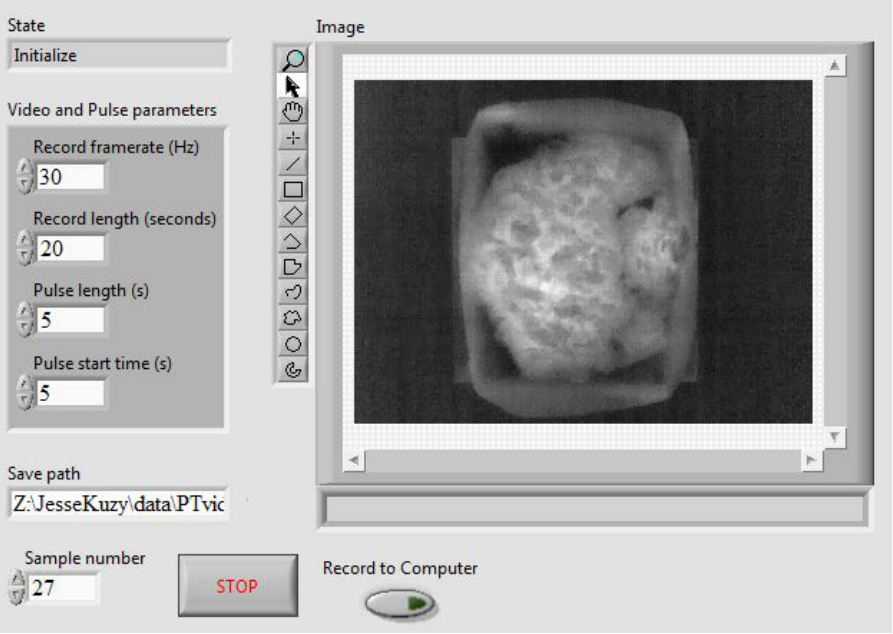
Figure 5. Pulsed thermography system automation virtual instrument front panel.